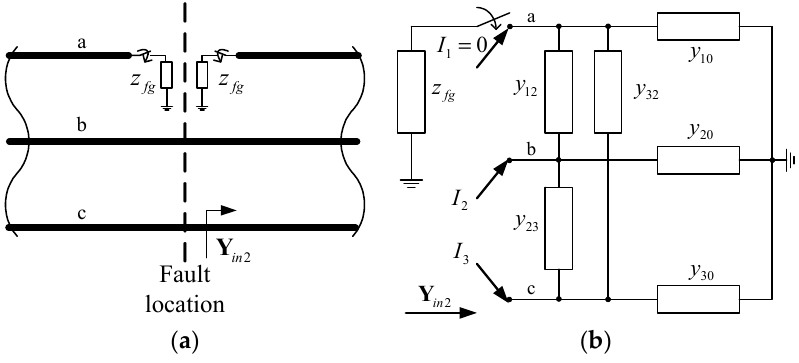
Figure 6. Schematically represented series fault. ( a ) Principle scheme; ( b ) Termination impedance at the fault location.